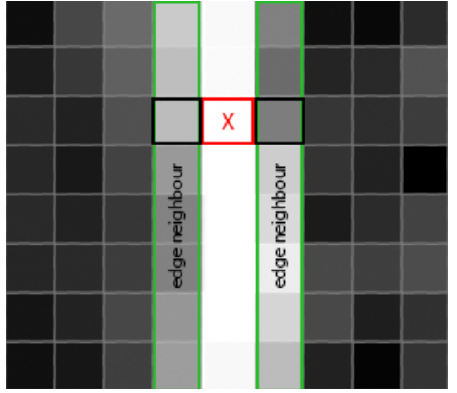
Figure 5. Example of a vertical edge.